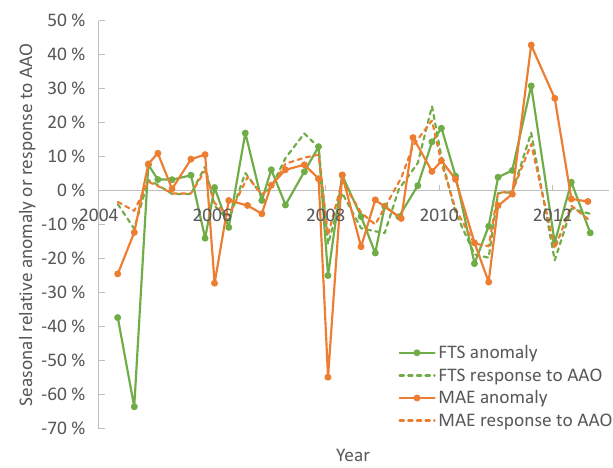
Figure 7. Seasonal median water vapour anomaly time series from MAESTRO (8.5km) and ACE-FTS (7.5km) in the Antarctic tro- posphere and the response of each to AAO determined by linear regression. Seasons with missing data are removed to avoid discon- tinuities. The markers on the response curves indicate the sampled seasons.